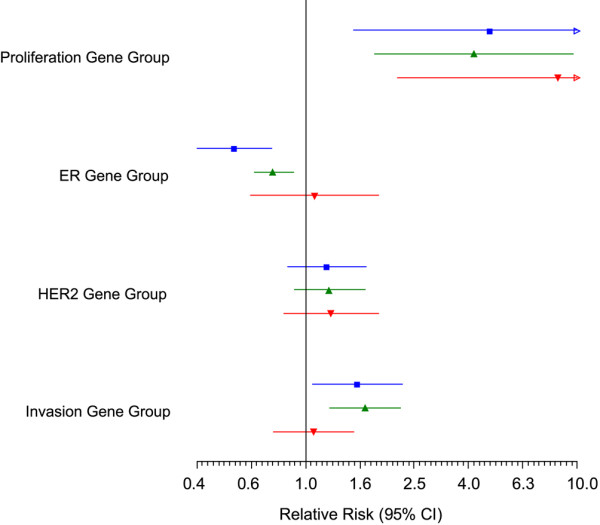
Relative risks (RRs) of death associated with gene group scores used in calculation of the Recurrence Score. Findings are stratified by tamoxifen treatment and ER status. The position of each symbol indicates the RR. The length of the horizontal line through the symbol indicates the 95% CI. The blue boxes indicate the RRs and 95% CIs for ER-positive patients treated with tamoxifen, the green pyramids indicate the RRs and 95% CIs for ER-positive patients not treated with tamoxifen, and the red downward pointing triangles indicate the RRs and 95% CIs for ER-negative patients not treated with tamoxifen. CI, confidence interval; ER, estrogen receptor; RR, relative risk.